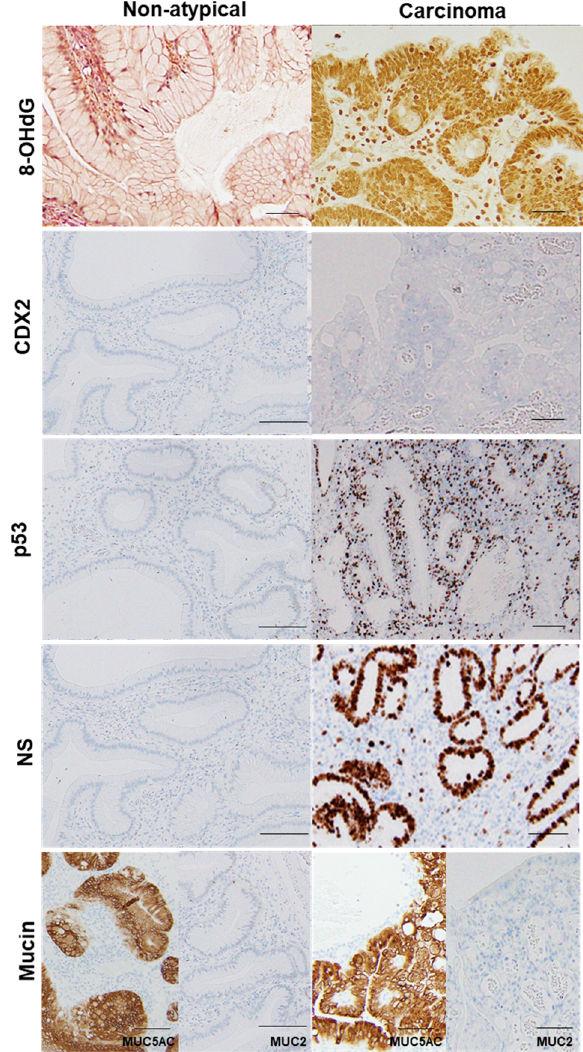
Figure 3. Comparison of oxidative stress, intestinal phenotype, and stemness between hyperplastic polyp and its carcinoma lesion. Table 2. Relationship between atypia and granulation tissue, oxidative stress, or stemness.